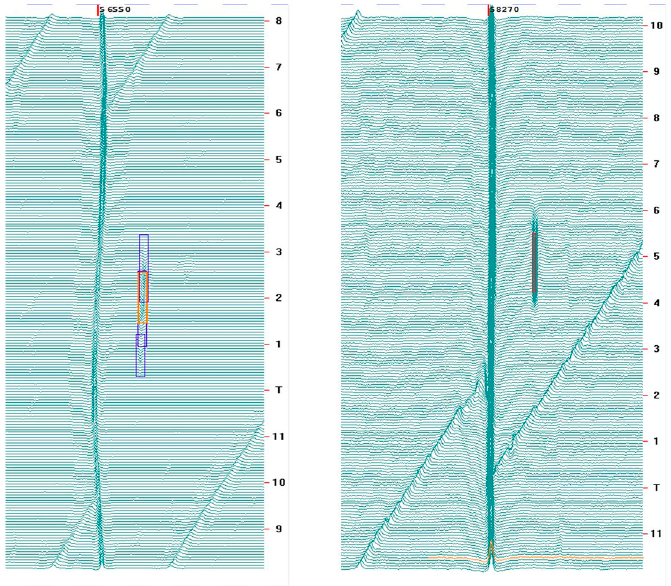
Figure 4. Type 2 MFL signals.